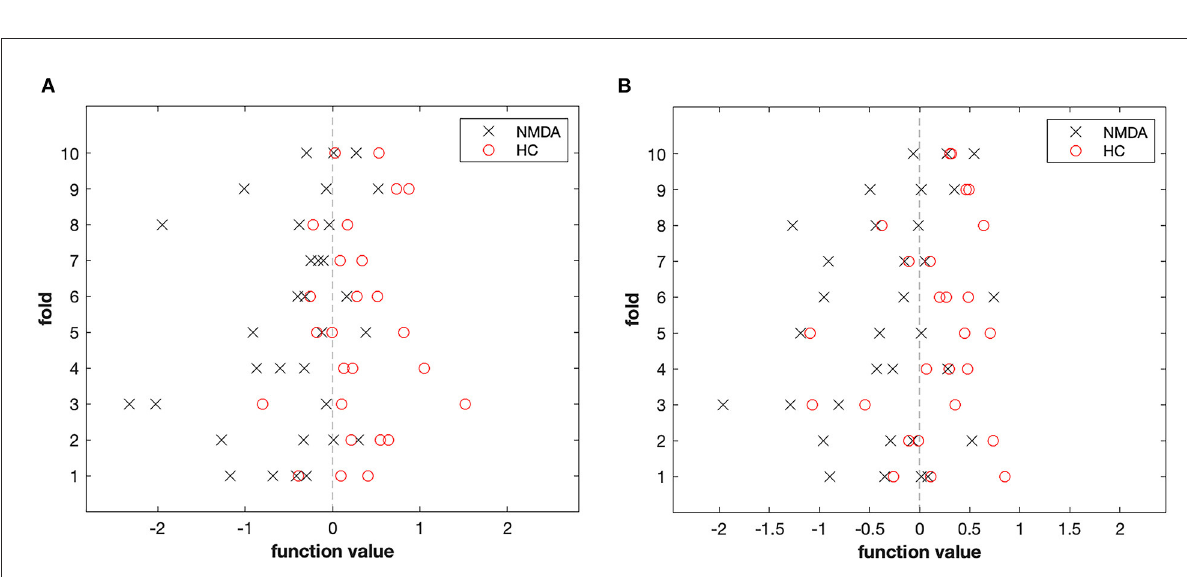
FIGURE5 The result of the MVPA classification between 32 patients and 26 controls based on FA (A) and RD (B) derived from DTI